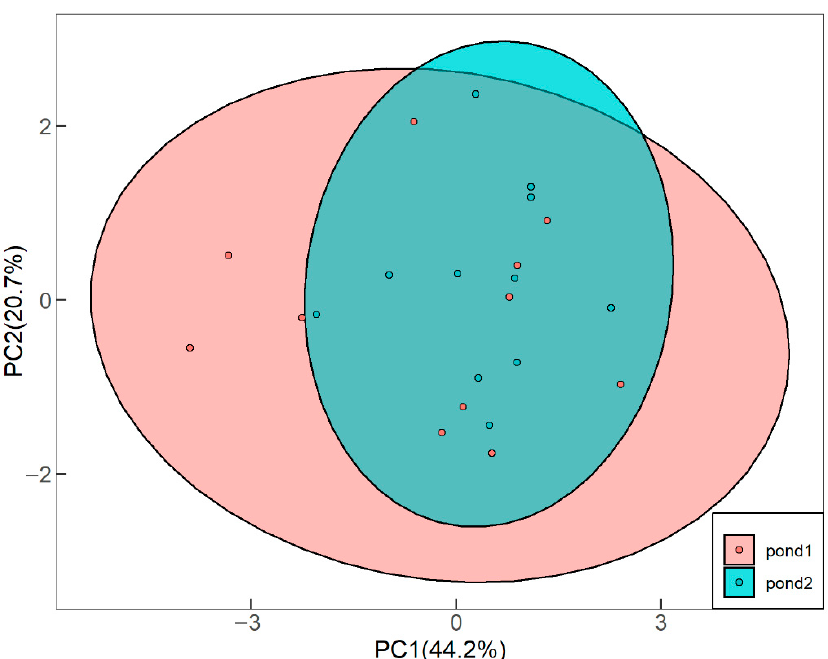
Figure 10. Biplot from PCA analysis of the distribution of water samples collected in Pond 1 and Pond 2. Compared with Pond 1, samples collected in the baffled pond have a smaller weighting in PC1 and similar significance in PC2.